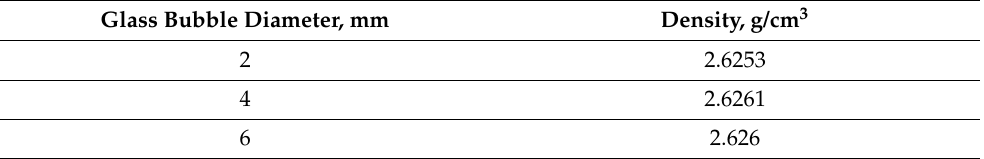
Table 1. Characteristics of glass spherical particles at different diameters.